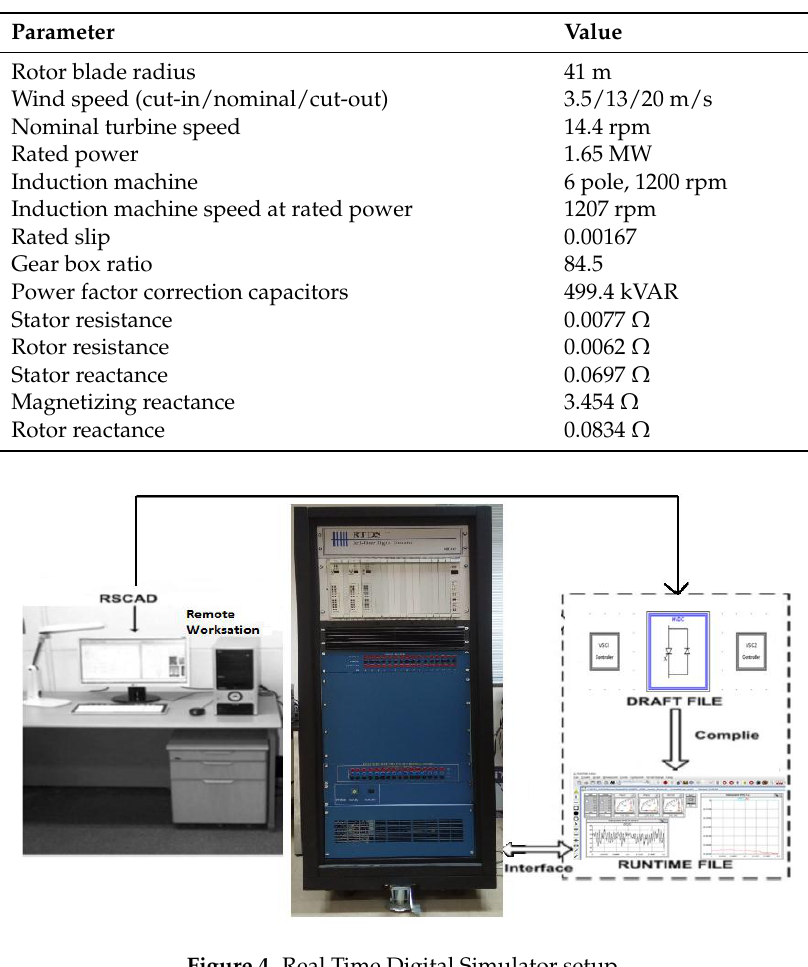
Table 2. Wind system parameters.